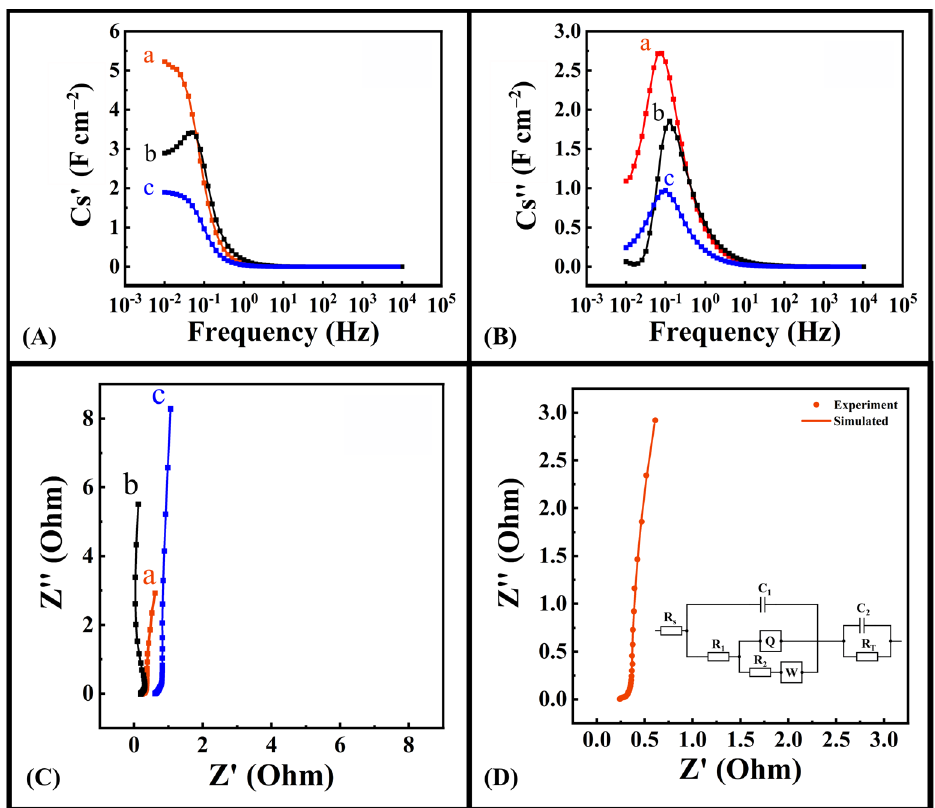
Figure 6. ( A ) Real part of capacitance (Cs’) vs. frequency, ( B ) imaginary part of capacitance (Cs”) vs. frequency, and ( C ) Nyquist plot for Fe 3 O 4 –MWCNT electrodes prepared with (a) DHBA as dispersing agent, (b) BA as dispersing agent, and (c) no dispersing agent, and ( D ) modelling of impedance for Fe 3 O 4 electrode prepared using DHBA and corresponding equivalent circuit (inset).